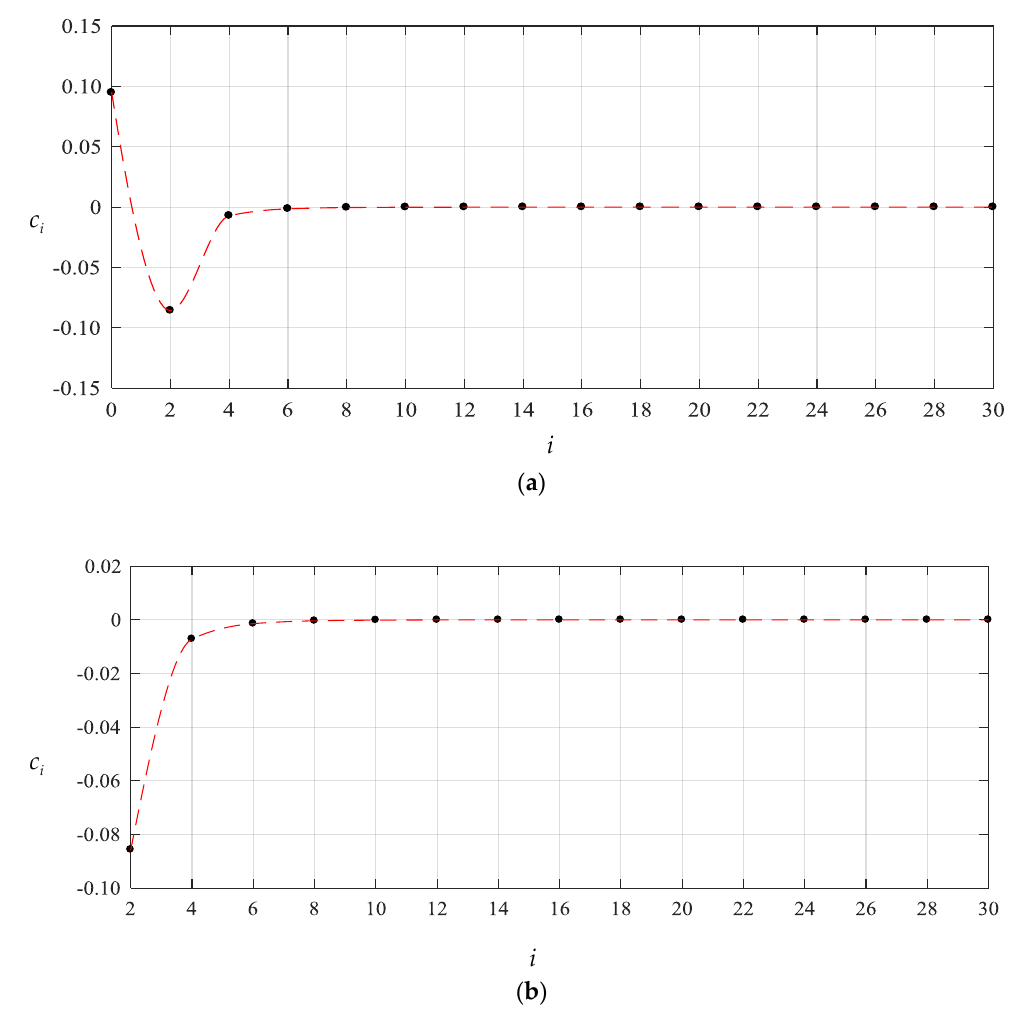
Figure 7. Variation of c i with i for n = 30, where ( a ) for i = 0,2,4, 6, ... ,30 and ( b ) for i = 2,4,6, ... ,30.